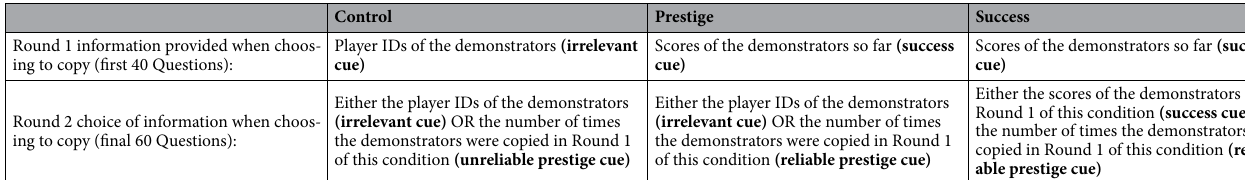
Control Prestige